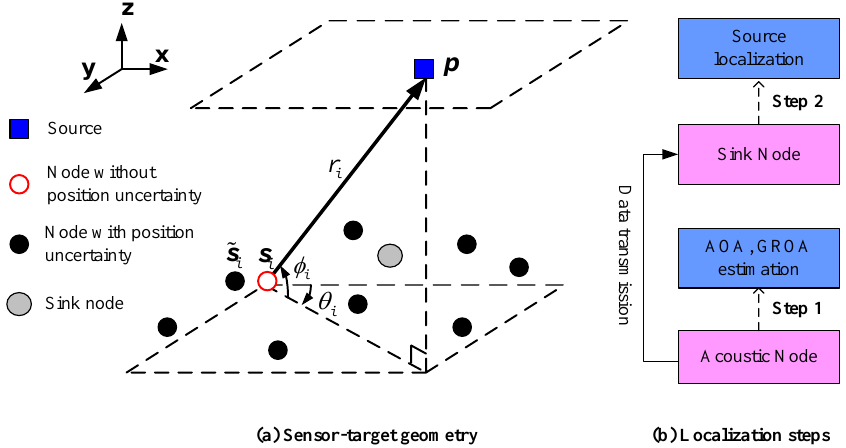
Figure 1. An example of 3D source localization for acoustic sensor